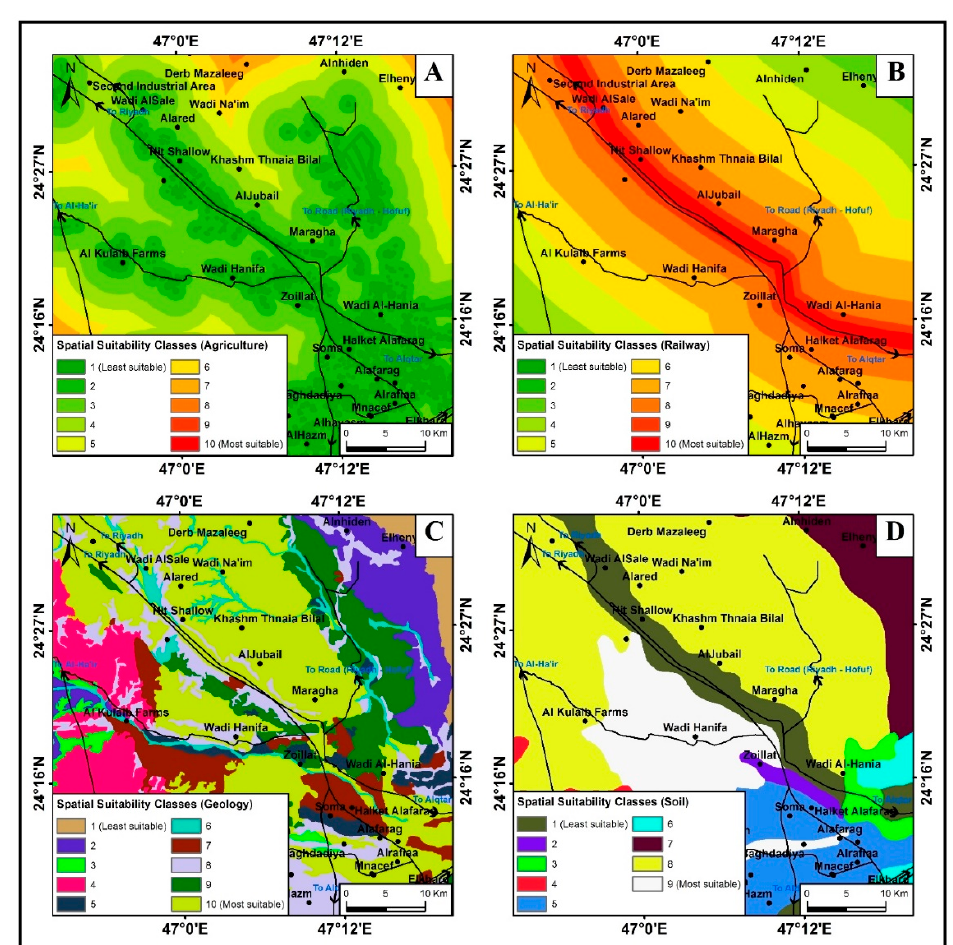
Figure 10. The spatial suitability (part 2) of ( A ) agriculture areas, ( B ) railways, ( C ) geology, ( D ) soil type.